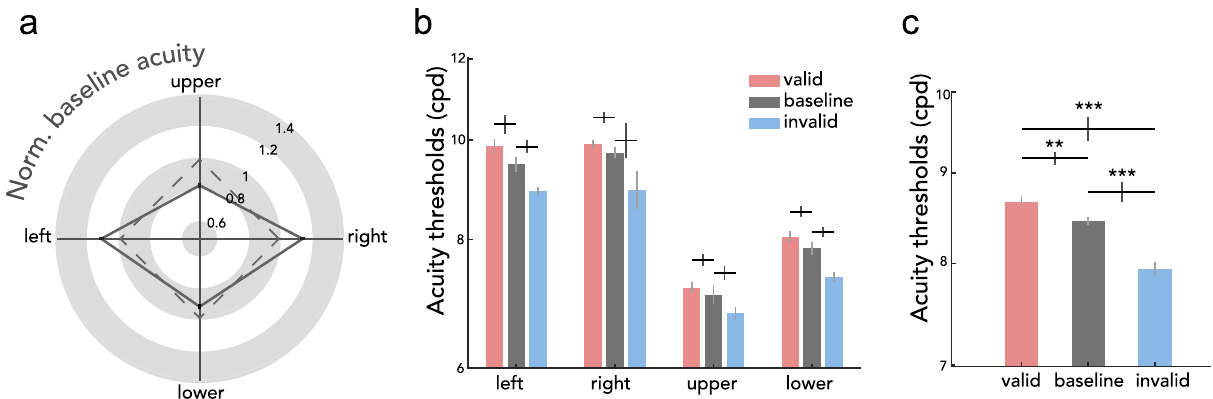
Figure 2. Main results. (a) Group averaged acuity thresholds in the baseline condition for each location normalized by participants’ averaged baseline threshold across (solid line). The black lines at each location depict ± 1 SEM. The dashed line illustrates a scenario in which there would be no asymmetries. Baseline visual acuity is better at the horizontal than the vertical meridian, and at the lower visual field than the upper visual field. (b) Acuity thresholds for each condition ( valid , baseline , invalid ) and location. Each condition demonstrates typical performance field asymmetries. (c) Acuity thresholds for each condition averaged across locations. Presaccadic acuity benefits at the saccade target ( valid ) and costs at non-target locations ( invalid ) compared to fixation ( baseline ). Y-axis is plotted in log-scale. Gray error bars in (b) and (c) depict ± 1 SEM (Cousineau corrected), black error bars depict ± 1 SEM of the difference between the compared conditions. ** p < 0.01, *** p < 0.001,